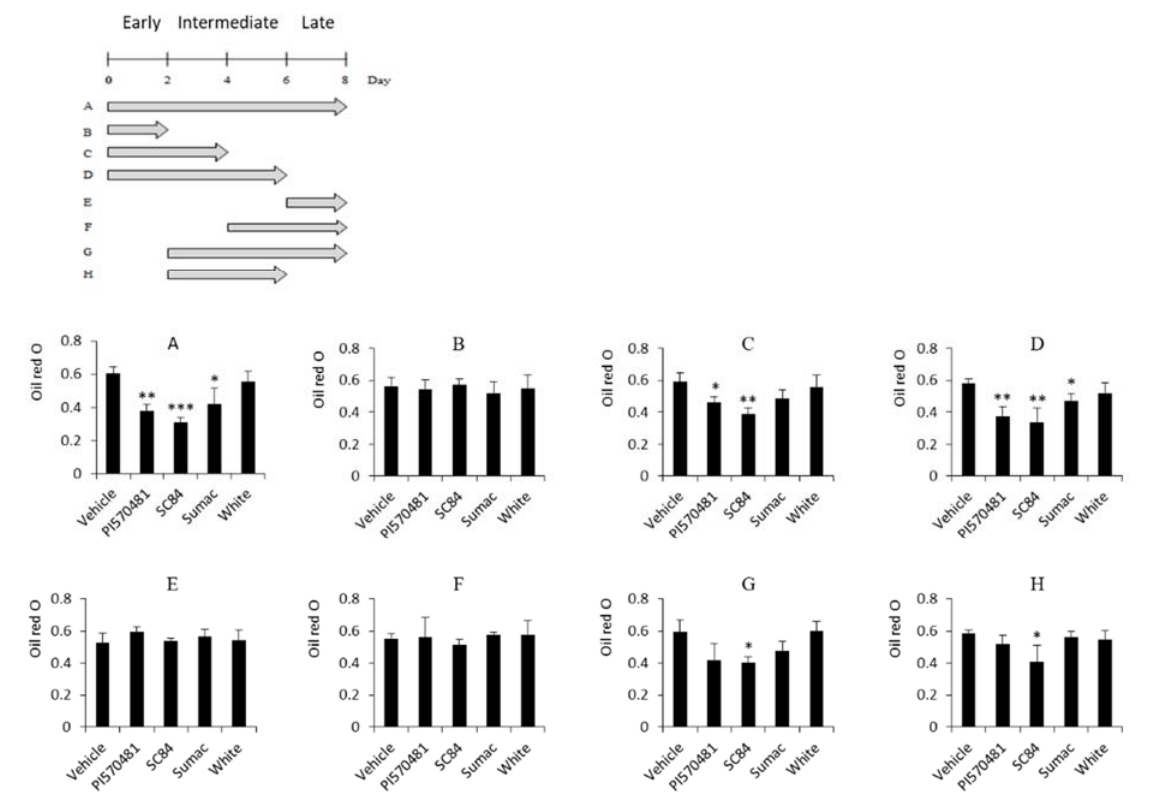
Figure 5. Anti-adipogenic activities of sorghum bran extracts depends on the early phase of adipo- genesis. ( A – H ) ORO staining from differentiated 3T3-L1 cells treated with 2.5 mg/mL of sorghum extracts (PI570481, SC84, Sumac, white) for different times. Schematic diagram on the top shows time frame for treatment of sorghum bran extracts. Values are means ± SD ( n = 3). Significance is indicated as * p < 0.05, ** p < 0.01, *** p < 0.001. Difference is between vehicle (0 mg/mL-treated) and treatment group. → : Incubation time with sorghum bran extracts.